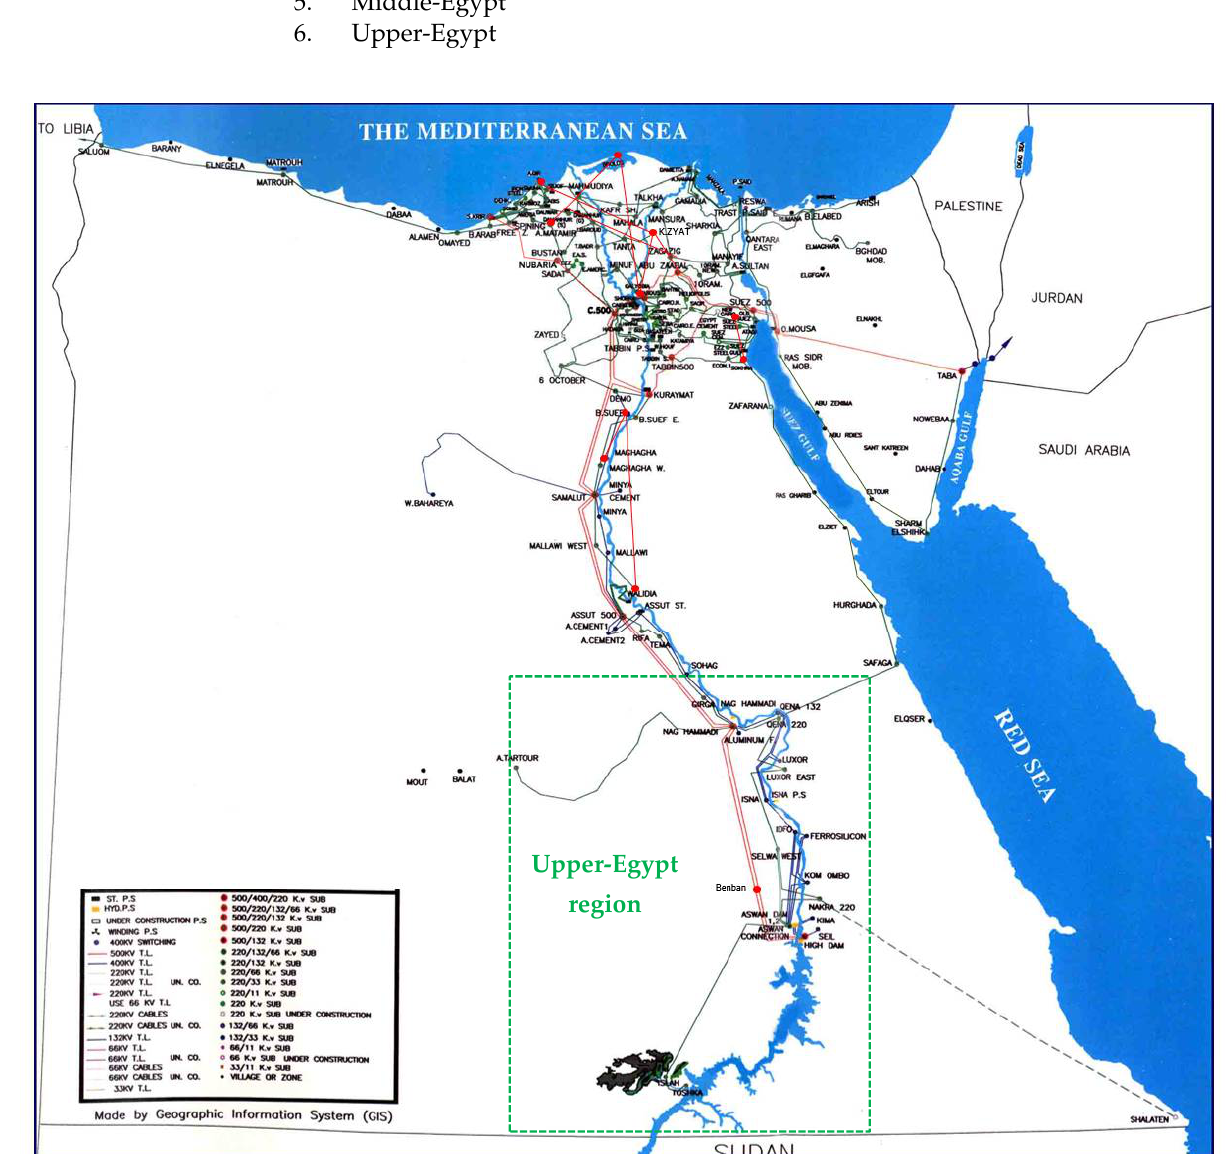
Figure 1. The Egyptian grid.